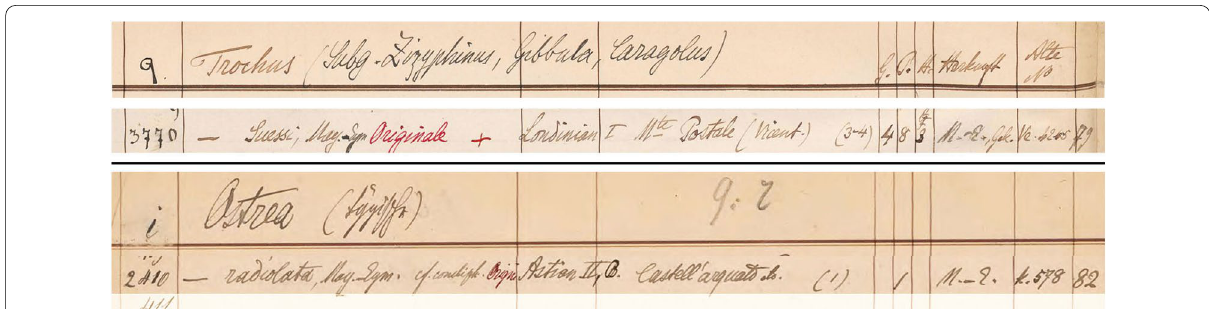
Fig. 12 Inventory entries for Trochus suessi above and Ostrea radiolata in the stratigraphic-systematic booklets Tertiary 19, Prefix g, and Tertiary 06, Prefix i. Compare with the corresponding “new” labels in Fig.